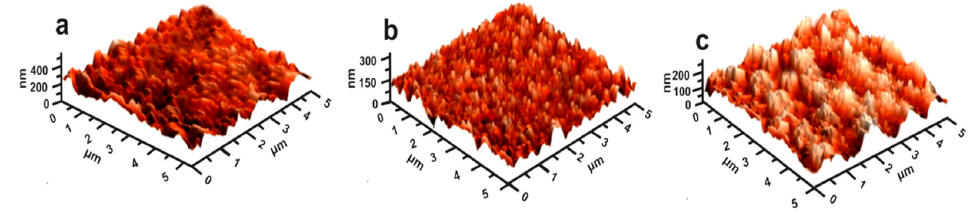
Figure 13. The AFM results of cement made by nano MgO and fly ash additives: ( a ), group I, ( b ) group II, ( c ) group